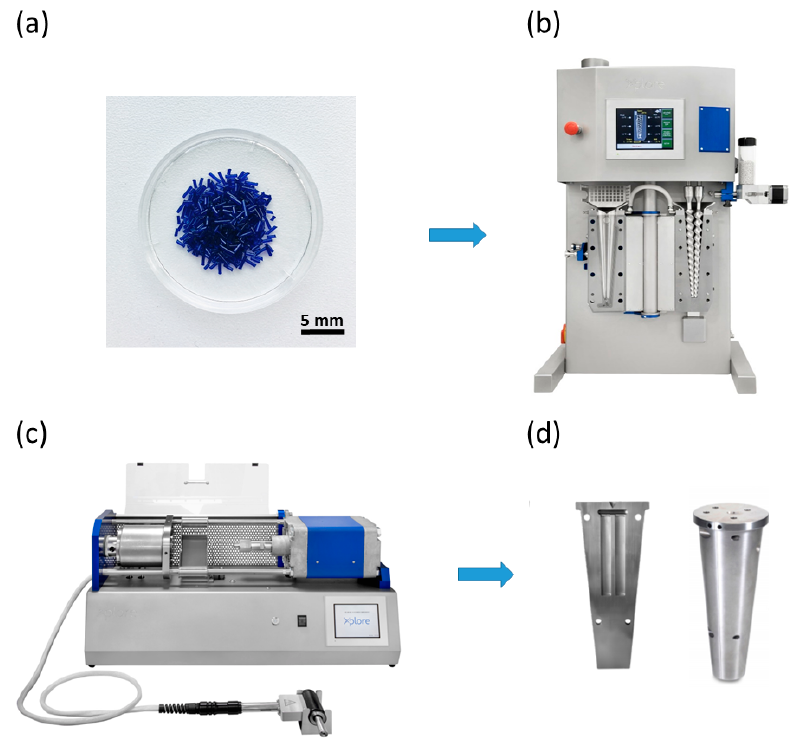
Figure 1. Scheme of the micro injection molding processing: PDO granulate − ( a ), twin-screw compounder − ( b ), micro injection machine − ( c ) and injection mold − ( d